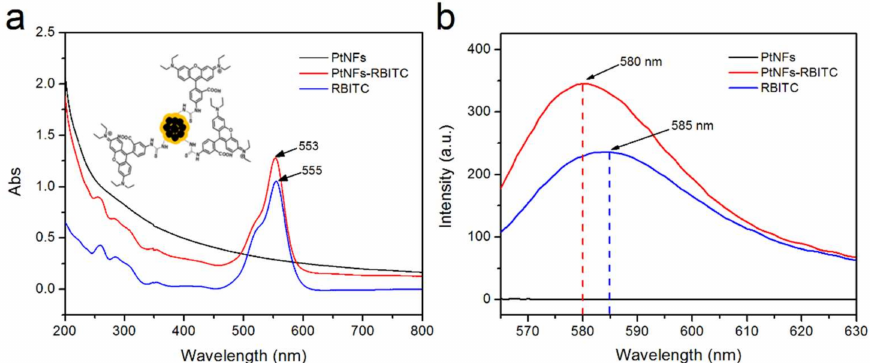
Figure 6. ( a ) UV-Vis absorbance spectra of Pt NFs (black spectrum), Rhodamine B Isothiocyanate (RBITC) labeled Pt NFs (Red spectrum), free RhB-ITC (blue spectrum). Insert shows the schematic illustration of RBITC labeled Pt NFs. ( b ) Fluorescence emission spectra ( λ exc = 555 nm) of Pt NFs, RBITC labeled Pt NFs,